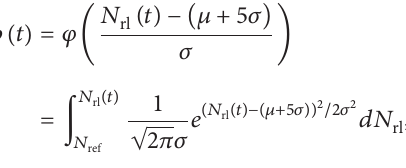
(i) solid line: the PID controller fails at 100 (s) with magnitude 4 and the safety relief valve fails at 190 (s) with magnitude 2; (ii) dashed-dotted line: the safety relief valve fails at 100 (s) with magnitude 1, the communication between and the PID controller is the sensor measuring 𝑁 rl interrupted at 136 (s), and the PID controller fails at 3917 (s) with magnitude